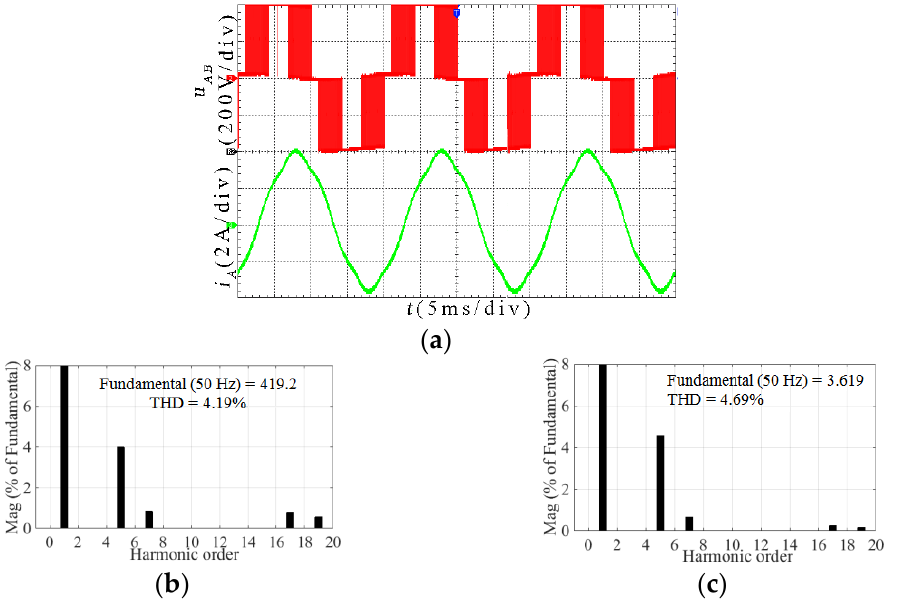
Figure 14. Experimental results for the HSOS at m = 0.605: ( a ) Line voltage u AB and line current i A ; ( b ) Spectrum analysis for u AB ; ( c ) Spectrum analysis for i A .